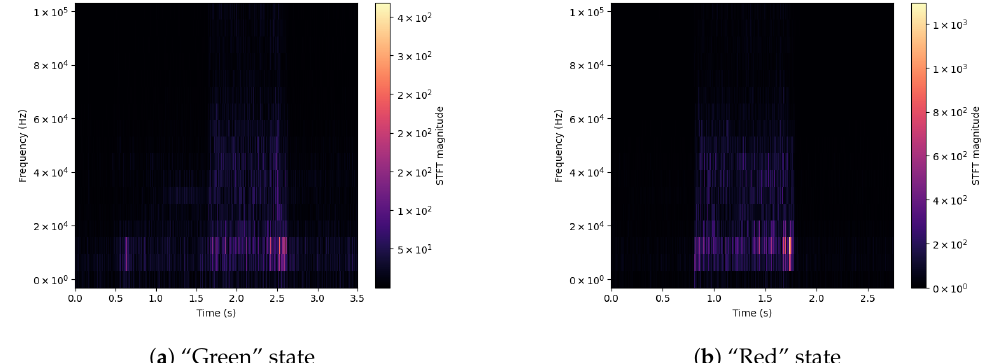
Figure 5. Signal spectrograms of Vibration for Green/Red states.